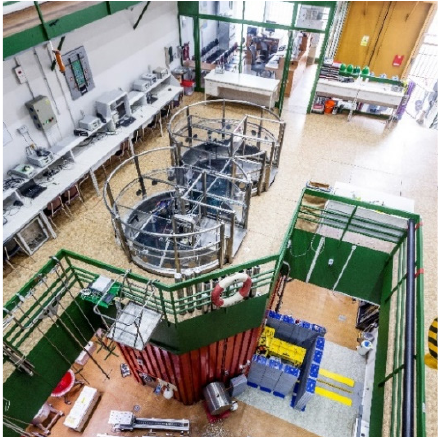
Figure 1. Research reactor VR-1.